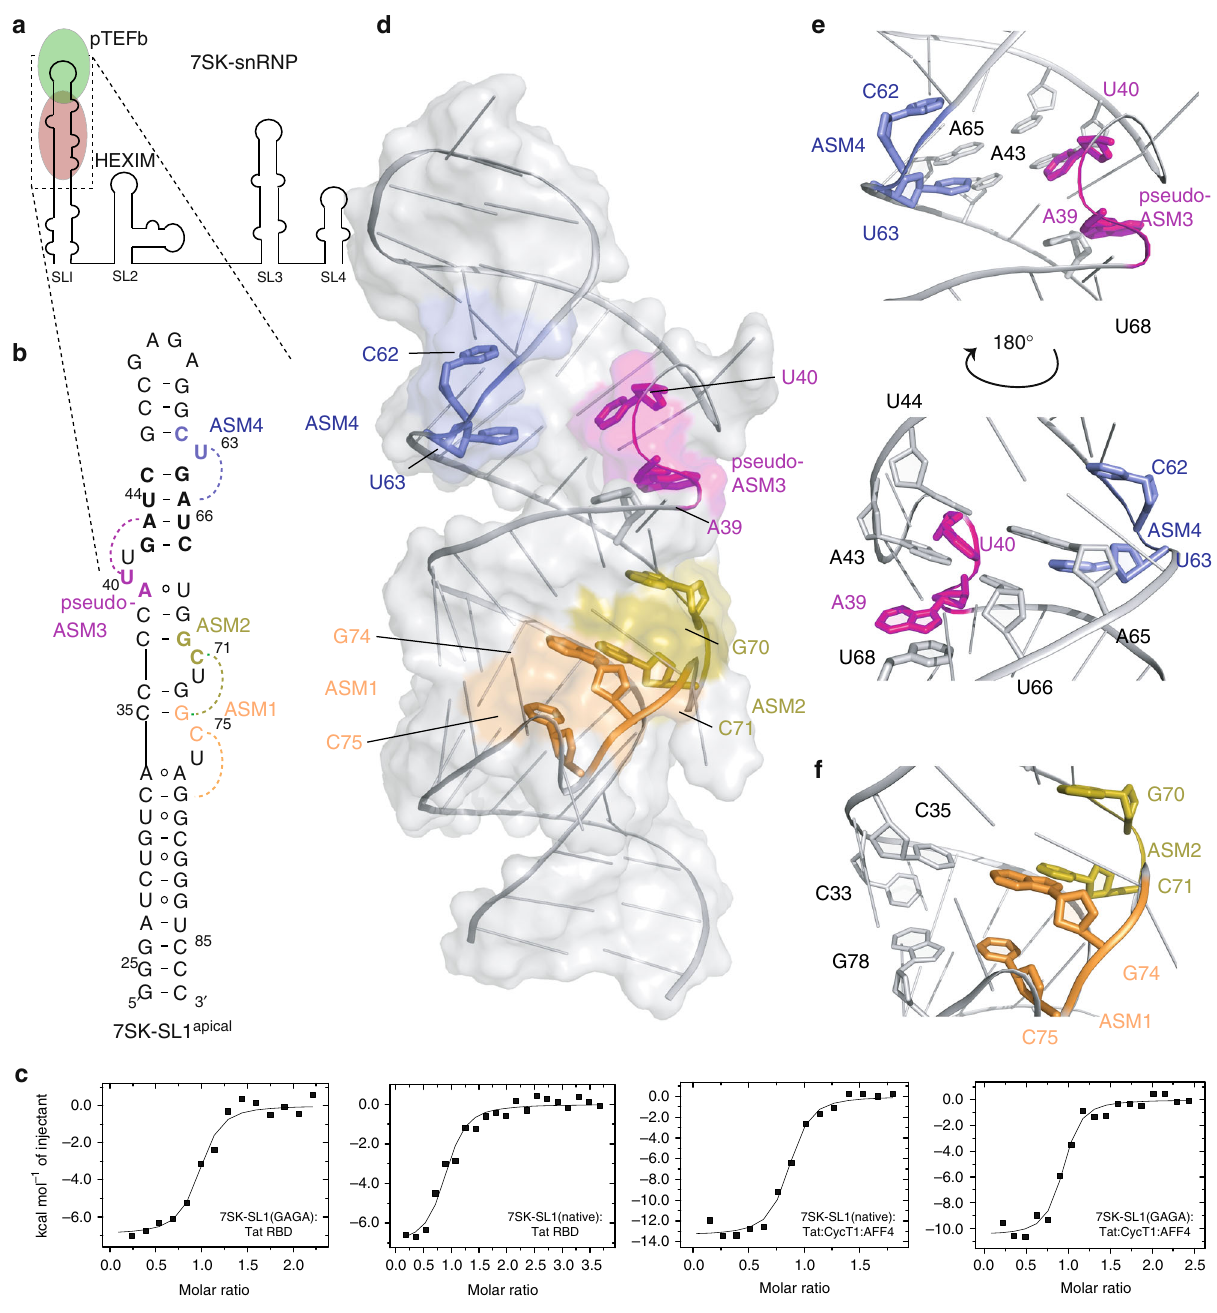
Fig. 1 Structure and characterization of free 7SK-SL1 apical . a Cartoon representation of pTEFb and HEXIM binding to 7SK-SL1 in 7SK snRNP. b Secondary structure of 7SK-SL1 apical with the base and cap residues forming ASM 1 , ASM 2 , pseudo-ASM 3, and ASM 4 colored in orange, olive, magenta, and blue, respectively. The dashed arcs represent the triple-base interactions from the bulge to the stem, giving rise to the roofs of the sandwiches. Nucleotides in bolded black represent the four palindromic base pairs involved in pseudo-ASM 3 and ASM 4 formation. c Representative ITC data for Tat RBD and Tat: CycT1:AFF4 binding to 7SK-SL1 apical with a GNRA or native loop, which show Tat RBD-mediated interactions are preserved in the larger complex. The continuous lines represent the fi t for a one-site binding model. d NMR structure of the free 7SK-SL1 apical RNA with color schemes matching the secondary structure in b . e 180 o rotated views of the apical, near-symmetric pseudo-ASM 3 and ASM 4 shows residues U 40 and U 63 forming triple bases with consecutive stem base pairs and A 39 sequestered in a reverse Hoogsteen base pair. f View of the tandem ASM 1 and ASM 2 shows that G 74 is involved in the formation of both sandwiching